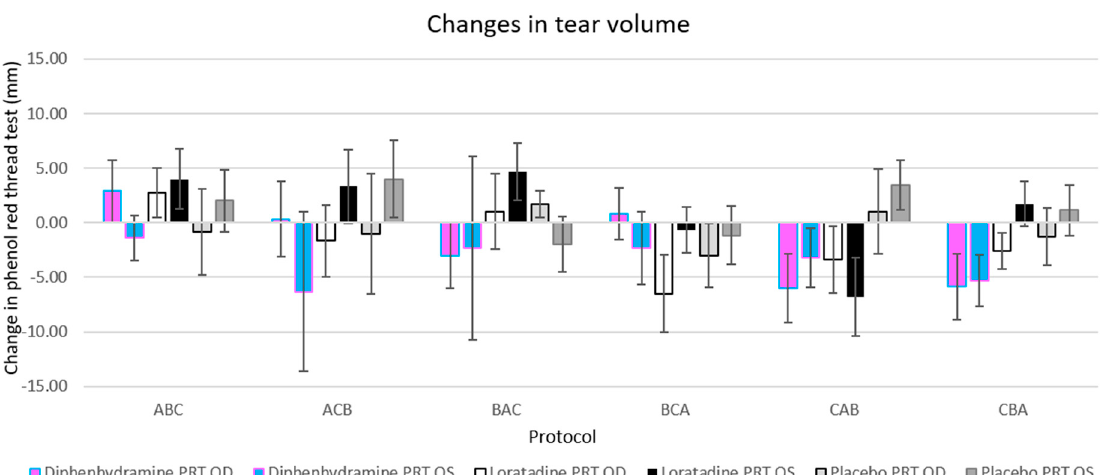
Figure 2. Changes in tear volume were equivalent when compared by protocol sequence. The only treatment that reduced the tear volume for all protocols was diphenhydramine in the left eye (light blue bars), but a post-hoc analysis (via Tukey honest significant difference (HSD)) showed no significant changes for multiple (six) treatments within each protocol. Error bars represent ±1 standard error of the mean (SEM).